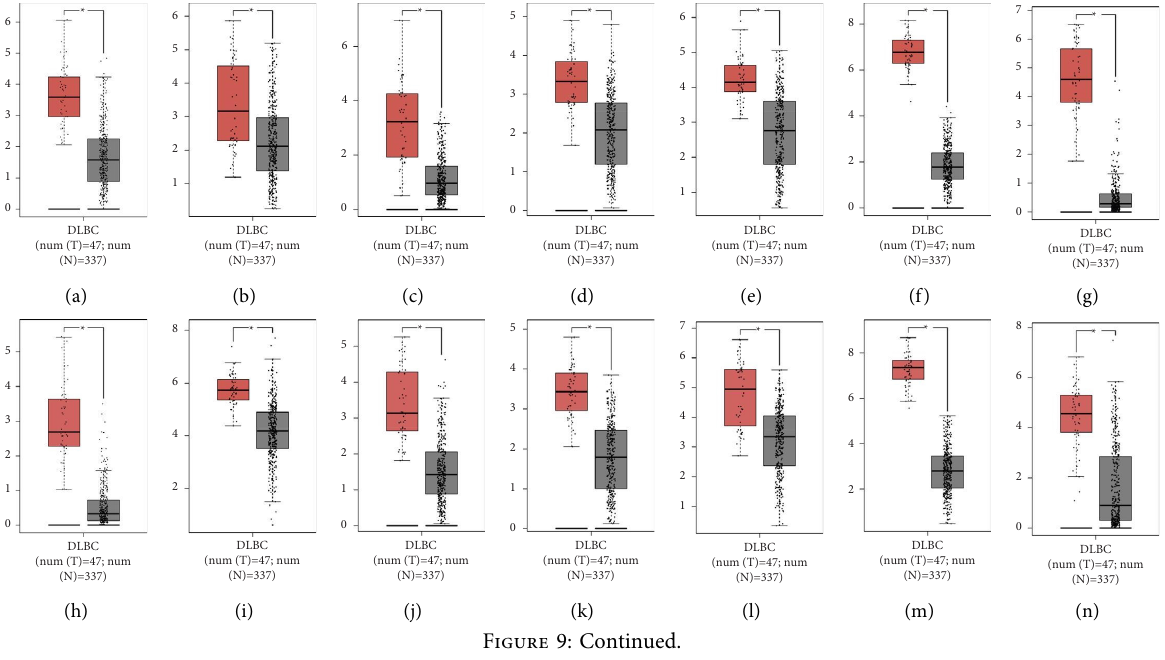
DLBC (num (T)=47; num